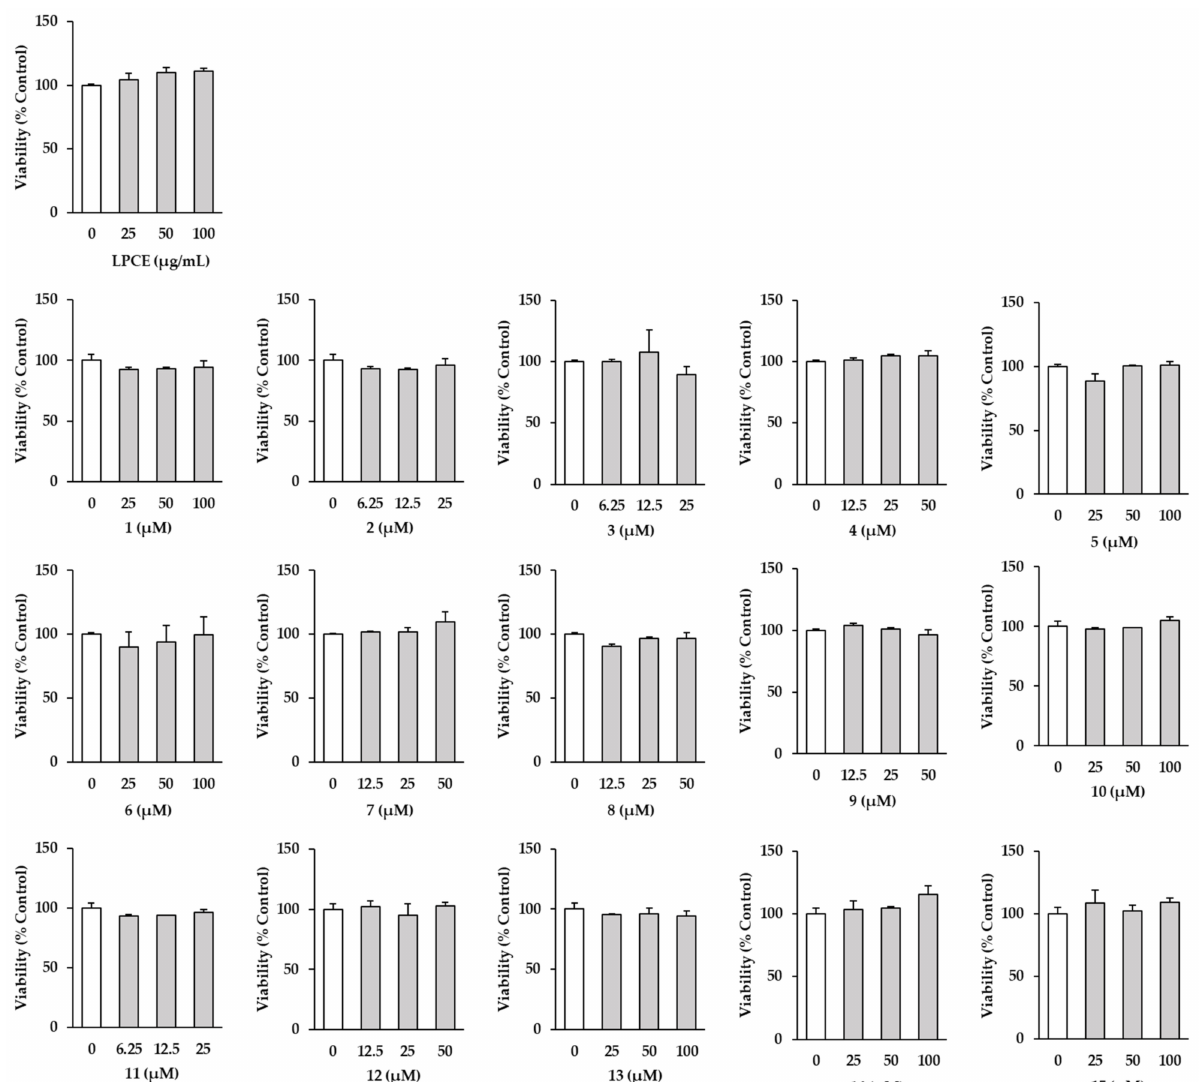
Figure 3. Effect of the extract (LPCE) and isolates ( 1 – 15 ) from P. chinensis on cell viability in HDFs. HDF cells were seeded in a 96-well cell culture plate at a concentration of 0.5 × 10 4 /well and incubated in starvation conditions with fresh media without FBS for 24 h. Then, the cells were treated with specific concentrations of LPCE and isolates for 24 h. The resulting values were determined using an EZ-Cytox solution Assay kit. The data are presented as mean ± SEM ( n =